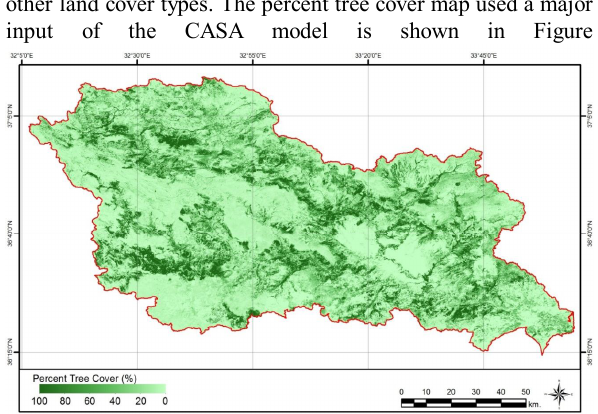
Figure 3. Percent Tree Cover Map of Goksu Watershed used a an input in CASA